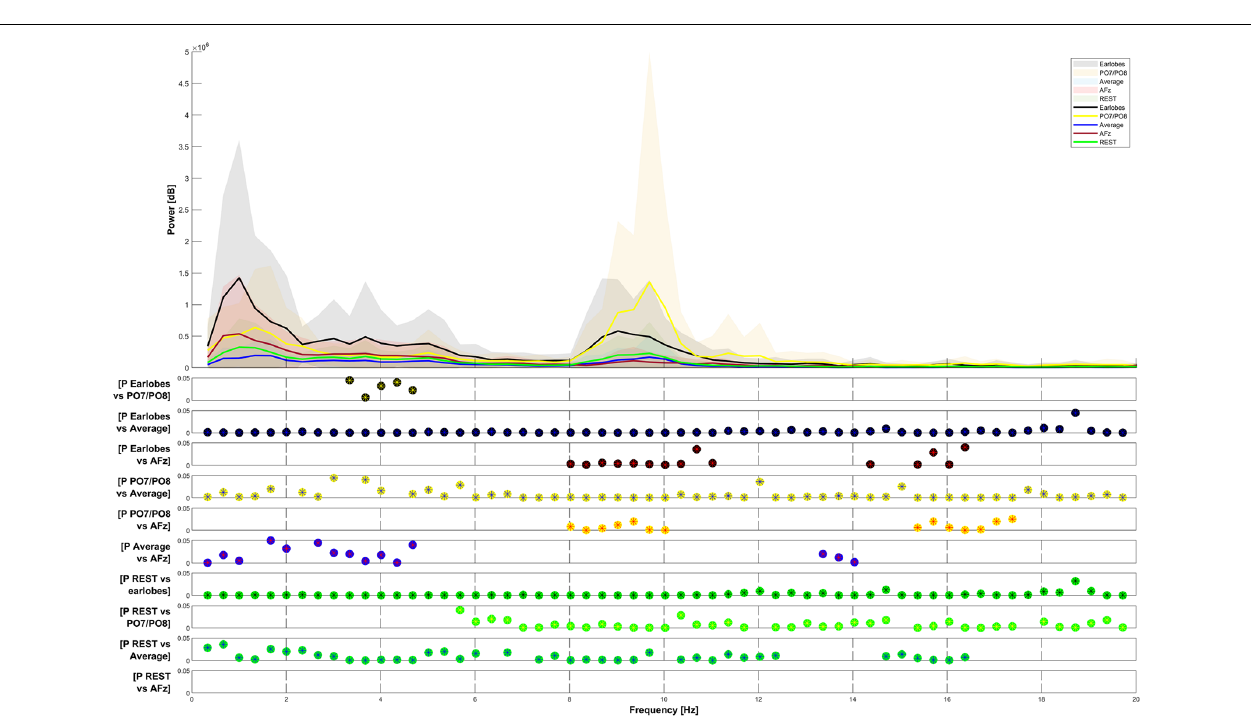
FIGURE 4 | Frequency-power plots for five selected reference sites. The Friedman test shows significance ( p < 0.05) for all observed differences. Post hoc analysis (Wilcoxon signed-rank with Bonferroni correction) has been plotted for data pairs in the lower half of the